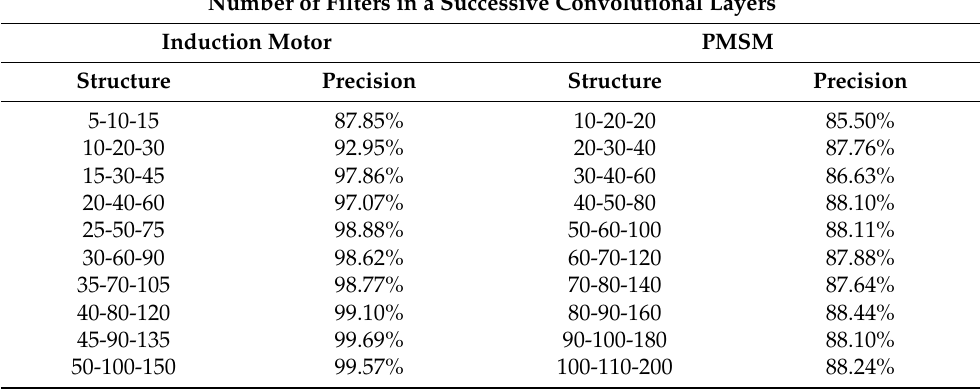
Table 2. Effect of the number of CONV filters on CNN